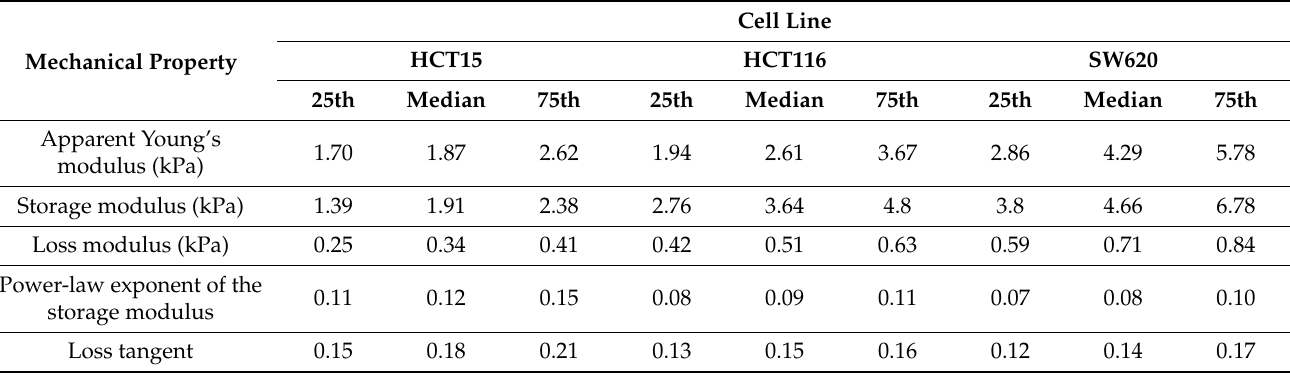
Table 1. Values of median and percentiles of Young’s modulus, storage modulus, loss modulus, power-law exponent applied to the storage modulus, and loss tangent quantification determined by AFM of HCT15, HT116, and SW620 cell lines.